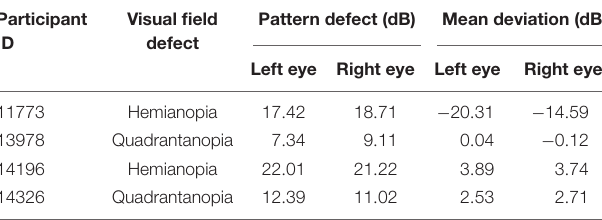
TABLE 2 | Perimetry results (standard clinical scores).